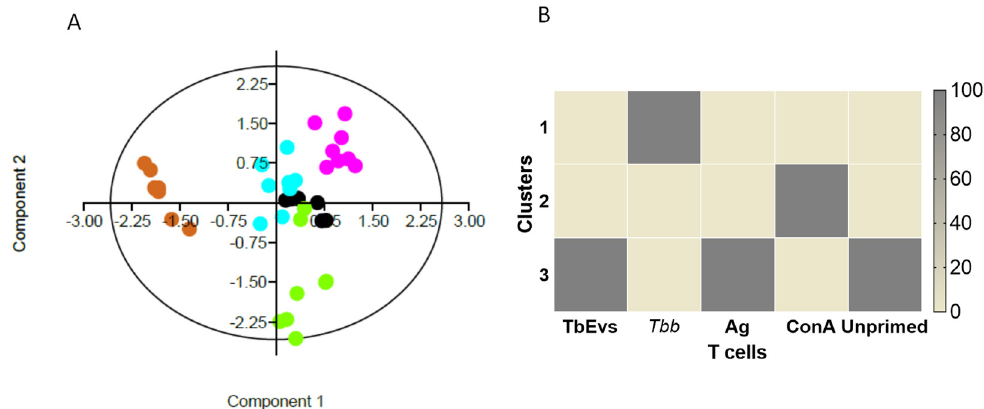
Figure 10. The effect TbEVs on mice T cells. Relationship between the effect of TbEVs (black dots), parasite Ag (blue dots), ConA (pink dots) and viable T. b. brucei trypomastigotes (brown dots) in CD3 + cells, including frequency of CD25 + , FoxP + , and CD25 + FoxP3 + subsets and the density of CD3, CD25, and FoxP3 molecules are represented by a variable correlation plot ( A ). In consequence of the low levels of CD3 + cells, the frequency and density of FoxP3 were not considered in T. b. brucei exposed-PBMC. Unprimed cells (negative control) are indicated by green dots. Cluster distribution of the effect TbEVs, parasite Ag, ConA, and trypomastigotes ( Tbb ) on T cells compared with unprimed cells (NC) are represented by the heat map ( B ).